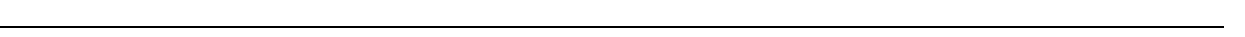
Fig. 3 Co-expression of IL-13R α 2 and EGFRvIII enhances glioma transformation. a Cell proliferation of Gli36.EGFRvIII and Gli36.IL-13R α 2/EGFRvIII. b The cell cycle pro fi le was compared between Gli36.EGFRvIII and Gli36.IL-13R α 2/EGFRvIII using fl ow cytometry analysis. c Soft agar colony formation assay of the indicated cells was performed, including the non-transforming Gli36 cells as a negative control. d IL-13R α 2 silencing (as validated by immunoblot presented as an insert) signi fi cantly reduced the proliferation of Gli36.IL-13R α 2/EGFRvIII cells to a level similar to the Gli36.EGFRvIII cells. e In vitro migratory capacity of Gli36.EGFRvIII and Gli36.IL-13R α 2/EGFRvIII cells. f U87MG.EGFRvIII cells were transfected with non-speci fi c siRNA (CTRL-RNAi) or IL-13R α 2 speci fi c siRNA (IL-13R α 2-RNAi). Cell proliferation was determined with CCK-8 assay in U87.EGFRvIII. The percent proliferation was normalized to CTRL-RNAi day 1. g In vitro migratory capacity of control and IL-13R α 2-RNAi treated U87MG.EGFRvIII was determined. Percent of migrated cells was normalized to CTRL-RNAi. All data are represented as mean ± SEM. ANOVA with Tukey's multiple comparison tests * p < 0.05; *** p < 0.001; NS not signi fi cant. h Kaplan − Meier survival curves of mice bearing Gli36.EGFRvIII and Gli36.IL-13R α 2/EGFRvIII tumors * p <